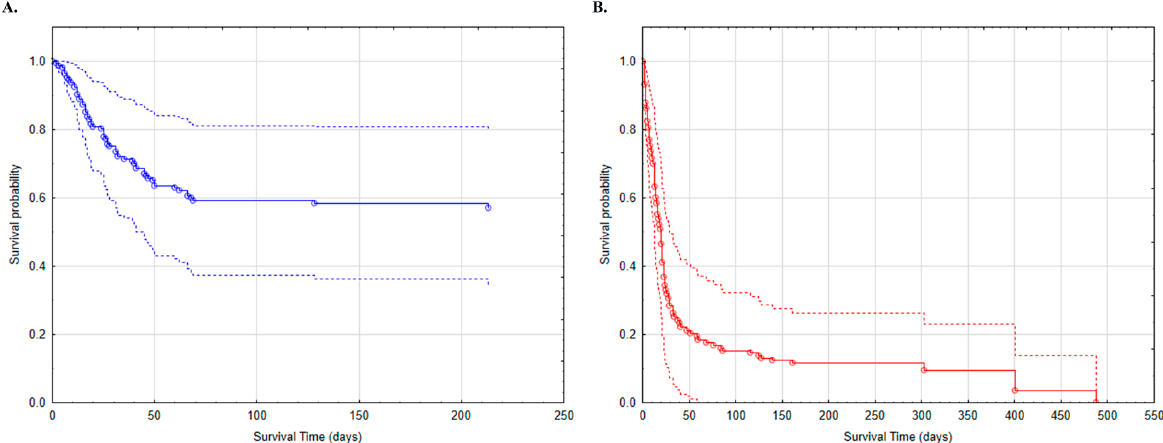
Figure 2. Survival analysis of patients with COVID-19 and impaired consciousness (somnolent/confusion) on admission to the hospital: ( A ) patients without cancer (blue); ( B ) patients with cancer (red).